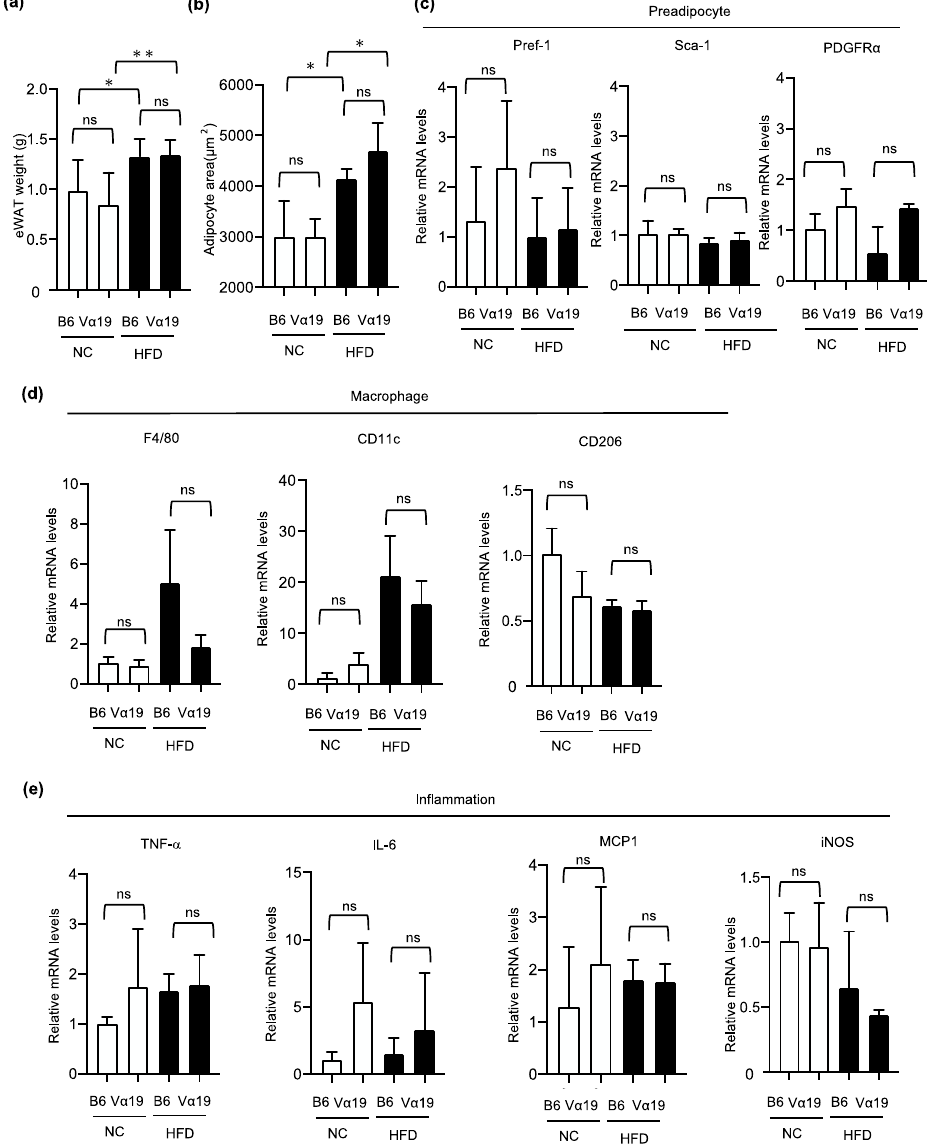
Figure 6. High-fat diet–induced inflammatory remodeling of epididymal adipose tissue was not altered in V α 19 mice. ( a , b ) Weight ( a ) and mean adipocyte size ( b ) in epididymal adipose tissue (eWAT) from V α 19 mice (V α 19) and C57BL/6 mice (B6) at 27 weeks of age fed normal chow (NC) and a high-fat diet (HFD). ( c – e ) mRNA levels of preadipocyte-related ( c ), macrophage-related ( d ), and inflammation-related ( e ) genes in V α 19 mice and B6 mice. Data on each mRNA were normalized according to the 36B4 mRNA level. * p < 0.05, ** p < 0.005, ns, not statistically